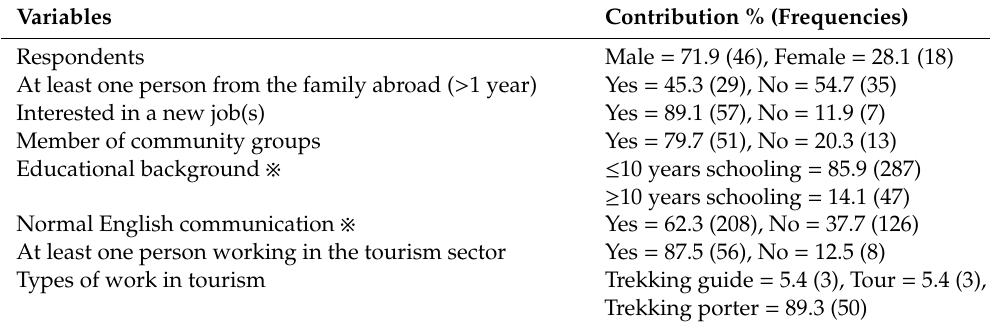
Table 2. Attributes of the